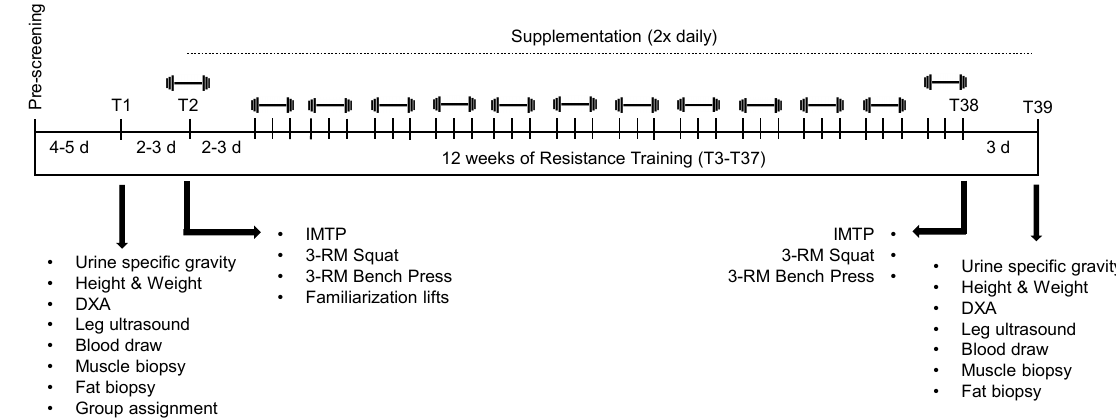
Figure 1. Study design. Abbreviations: DXA, dual x-ray absorptiometry; 3-RM, three-repetition maximum test; IMTP, isometric mid-thigh pull.